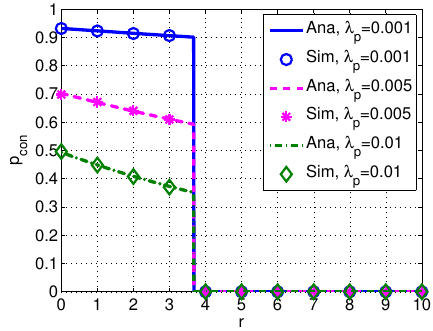
Figure 6. Probability of connection p con versus distance r with different intensity of PUs λ p . System parameters are set as k = 1, w = 10 m/s, f = 30 kHz, P p = 110 dB, P s = 100 dB, s = 1, δ s = 20 dB and δ d = 20